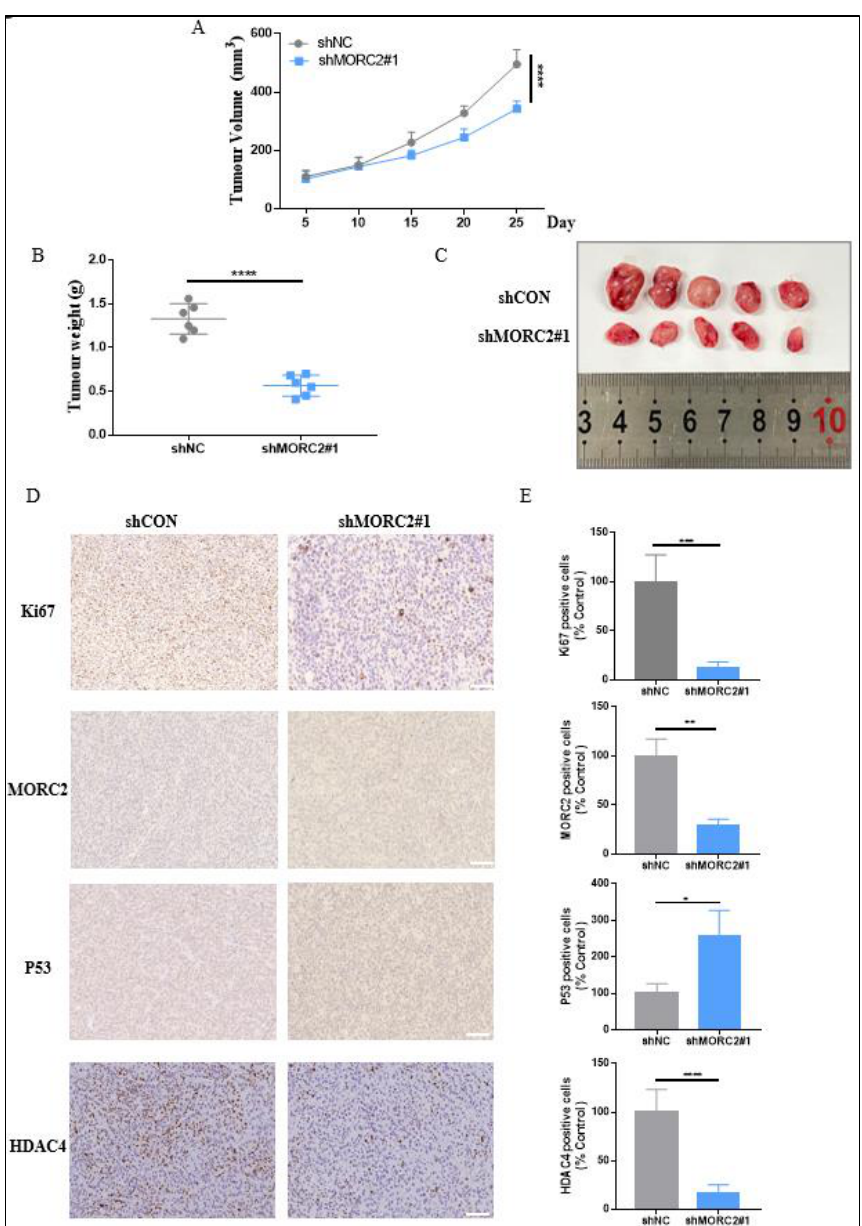
Figure 4. Knockdown of MORC2 inhibits tumor growth. ( A ) The growth curve of mice xenografts formed by shCON and shMORC2#1 cells ( n = 5). ( B ) Tumor weights after sacrificing the mice ( n = 5). ( C ) Mice xenografts formed by HCT-116 with or without MORC2 intervention. ( D , E ) IHC staining and statistical analysis of xenografts using antibodies against ki67, MORC2, p53, and HDAC4. * p < 0.05, ** p < 0.01, *** p < 0.001, **** p < 0.0001.